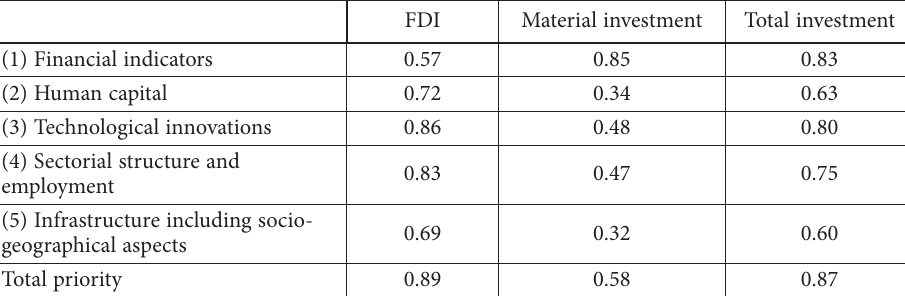
Table 3. The results of correlation of priorities for the Cities (made by